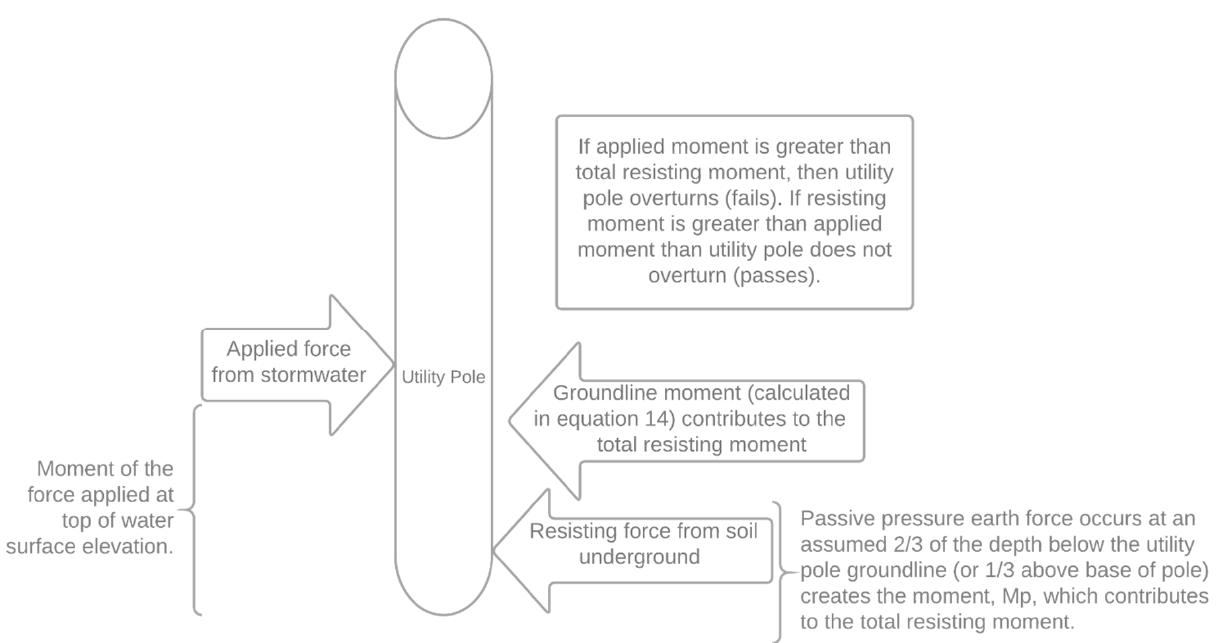
Figure 4. Diagram depicting forces occurring on utility pole from soil and stormwater.